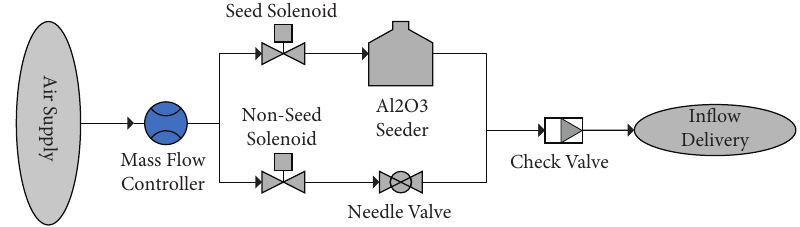
Figure 3: Schematic of secondary seed and nonseed flow.